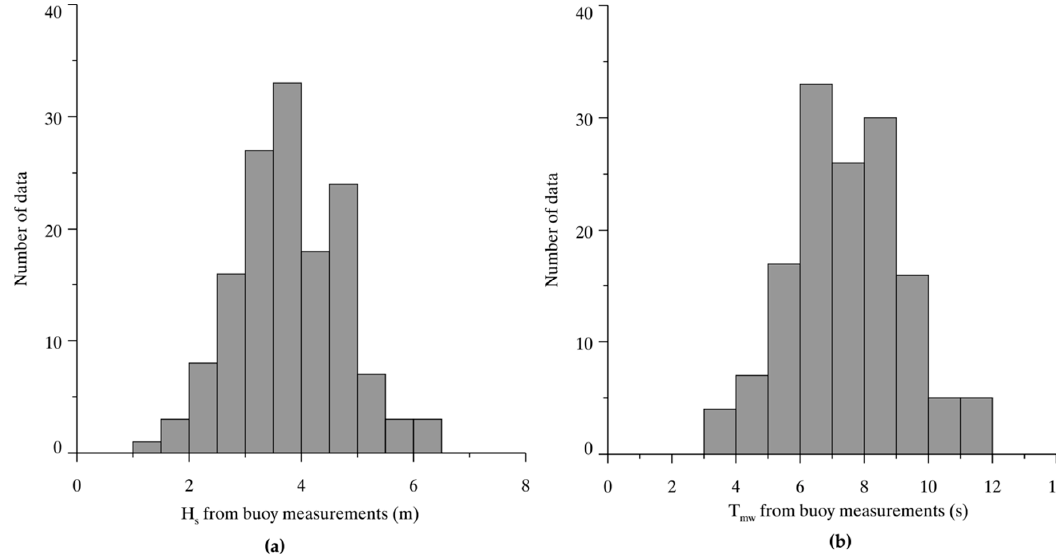
Figure 4. Histograms of buoy data ( a ) H s ranges from 1 to 7 m; and ( b ) T mw ranges from 3 to 12 s.